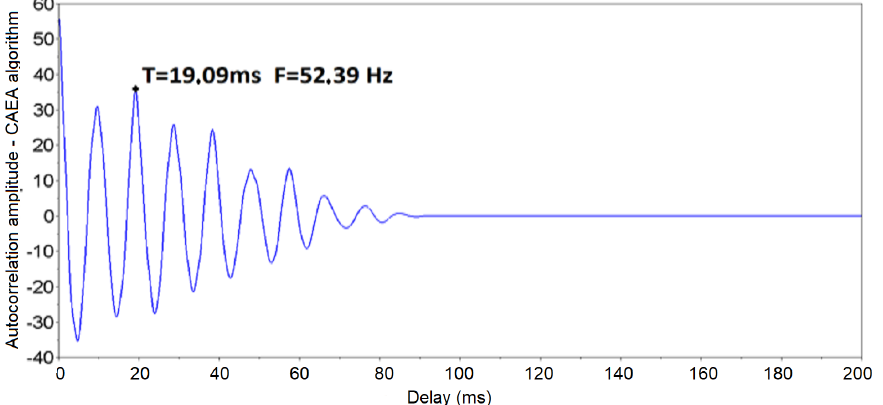
Figure 21. The CAEA algorithm (autocorrelation method) graph with peak location error referring to the fundamental frequency of A. fraterculus of the standard